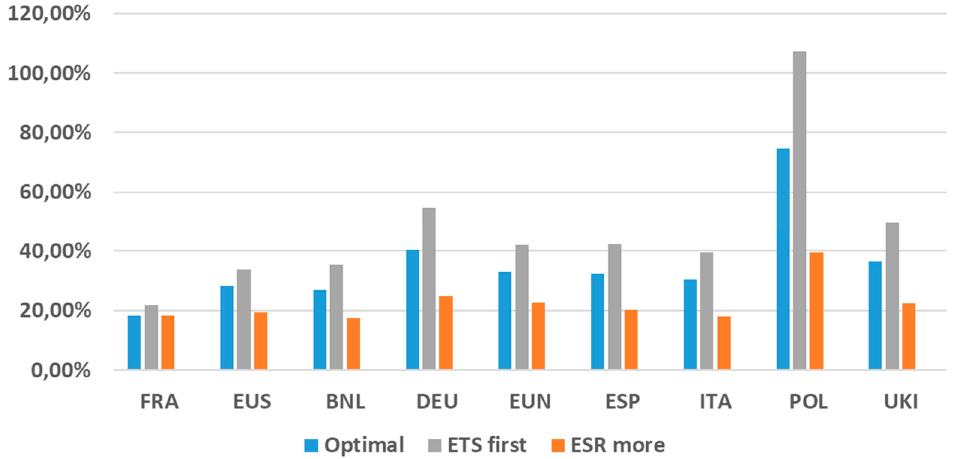
Figure A4. Deviation of EU27 + UK regional electricity prices in 2030 relative to the reference scenario.